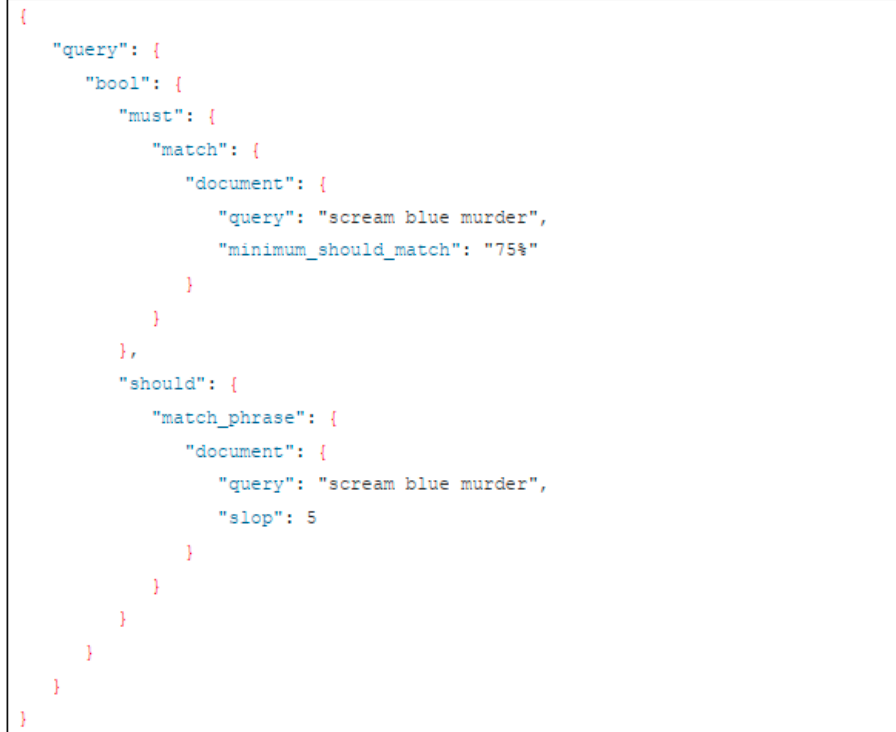
Figure 5. An example of a bool query.